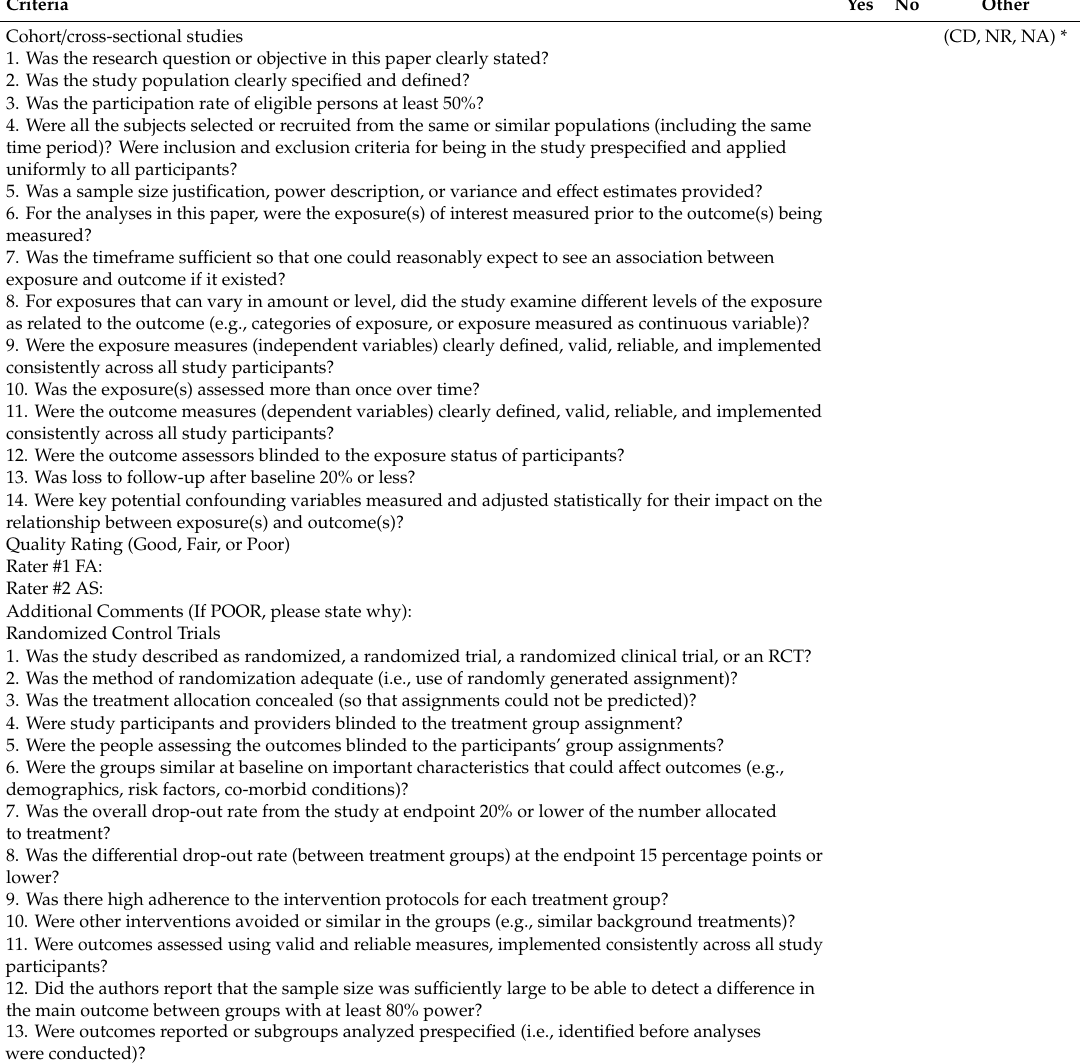
Table A1. The based on National Institutes of Health (NIH) study quality assessment tools for controlled trials 1